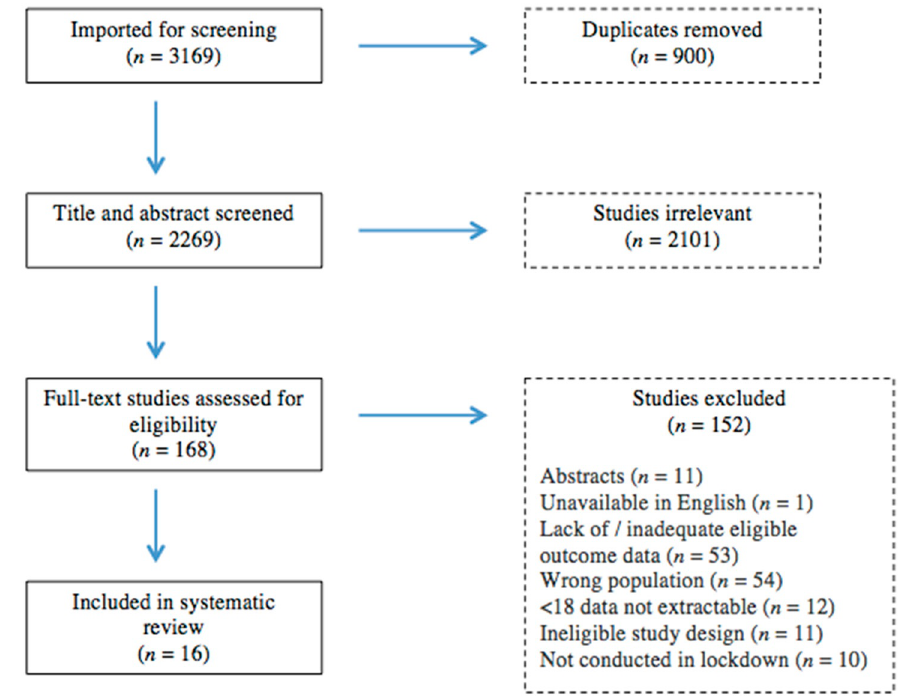
Figure 1. PRISMA flow chart .